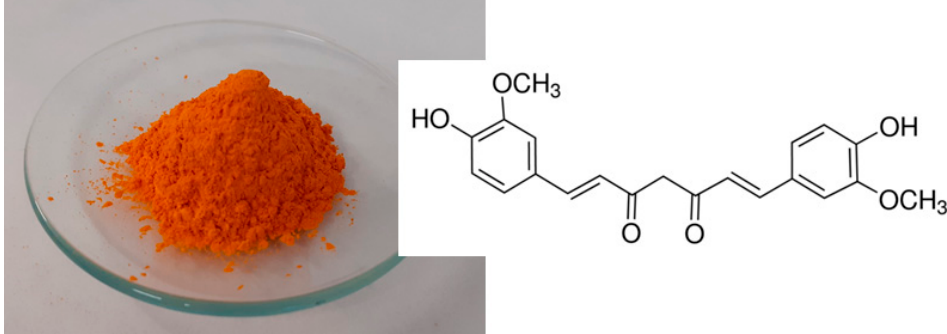
Figure 1. Picture of curcumin orange-colored powder and its molecular structure. Curcumin solutions are generally yellow at pH ≤ 7 and change to red at pH ≥ 8.5 [3]. However, due to its hydrophobicity, it is barely soluble in water. Poor solubility,